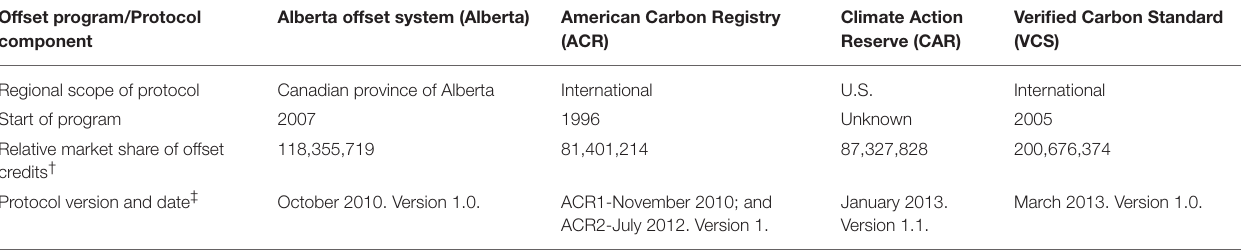
TABLE 1 | Greenhouse gas offset programs and agricultural nitrogen management protocols for North America. Offset program/Protocol